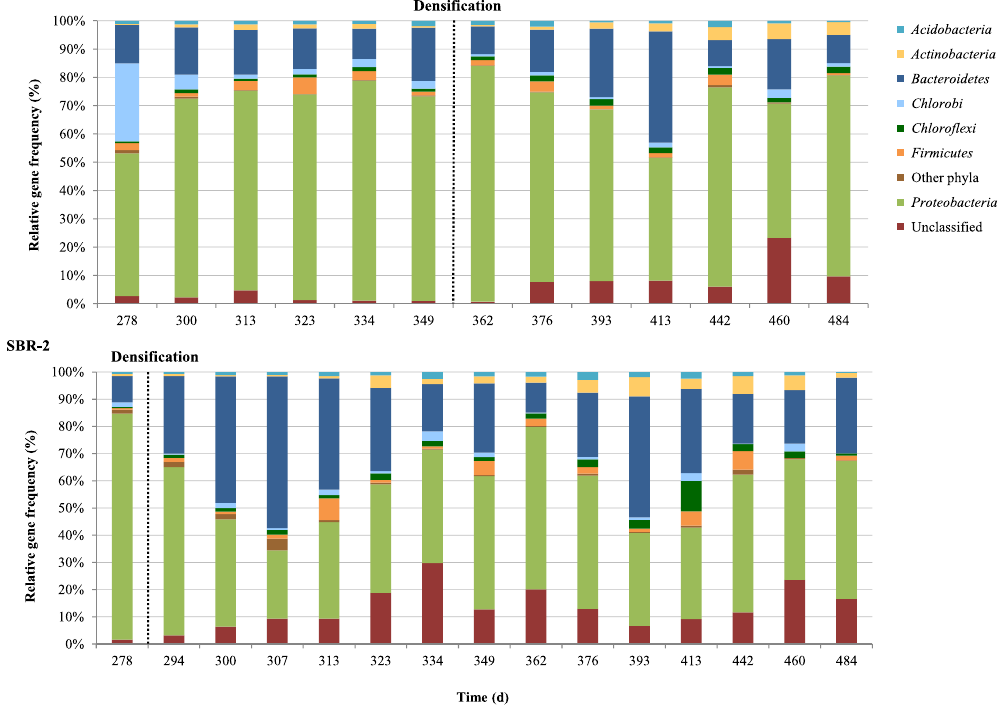
Figure 3. Distribution of the bacterial phyla in SBR1 (top) and SBR2 (bottom) between days 278 and 484. The abundance of each phylum is expressed as the relative gene frequency of the corresponding OTUs.